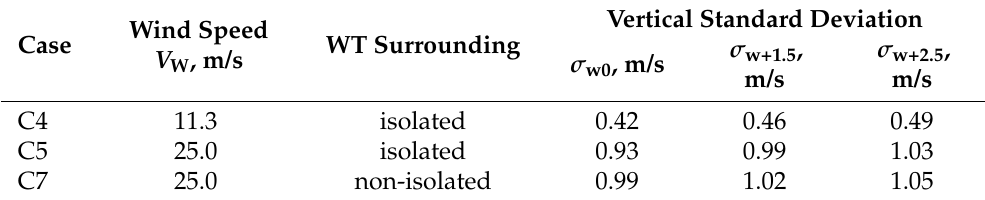
Table 4. Averaged standard deviation of the vertical velocity component σ w over the helicopter rotor area from WT flow field data C4, C5 and